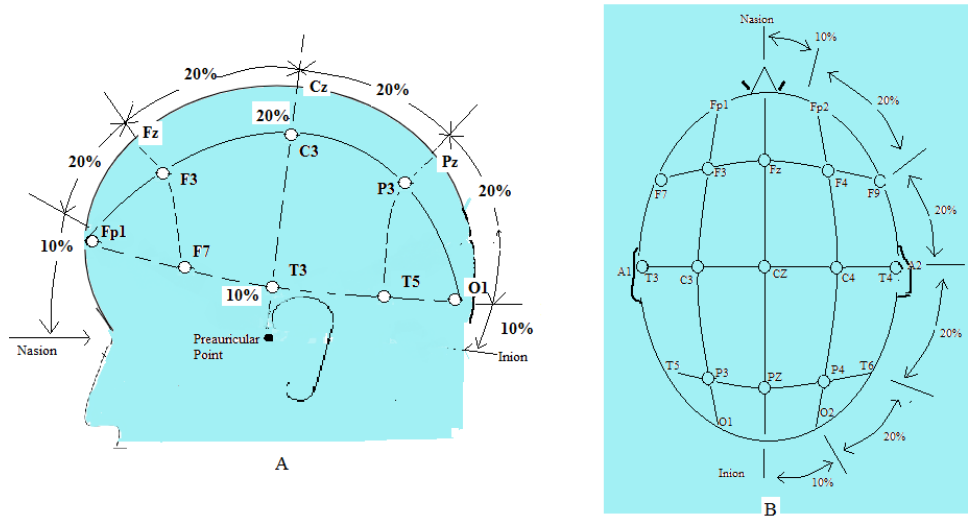
Figure 1. The international 10–20 system of the electrode [4]. Seen from ( A ) left and ( B ) above the head. A: earlobe, C: central, Pg: nasopharyngeal, P: parietal, F: frontal, Fp: frontal polar, O: occipital.